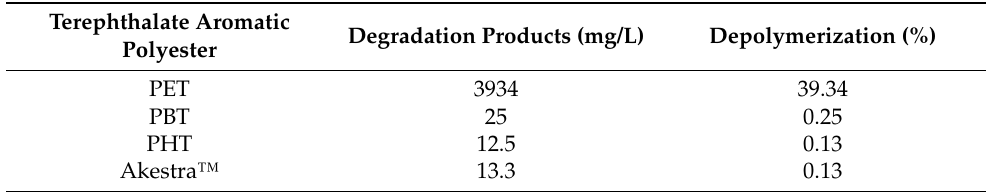
Table 3. Depolymerization of different terephthalate polyesters after 72 h with an Is PETase/substrate ratio of 0.01